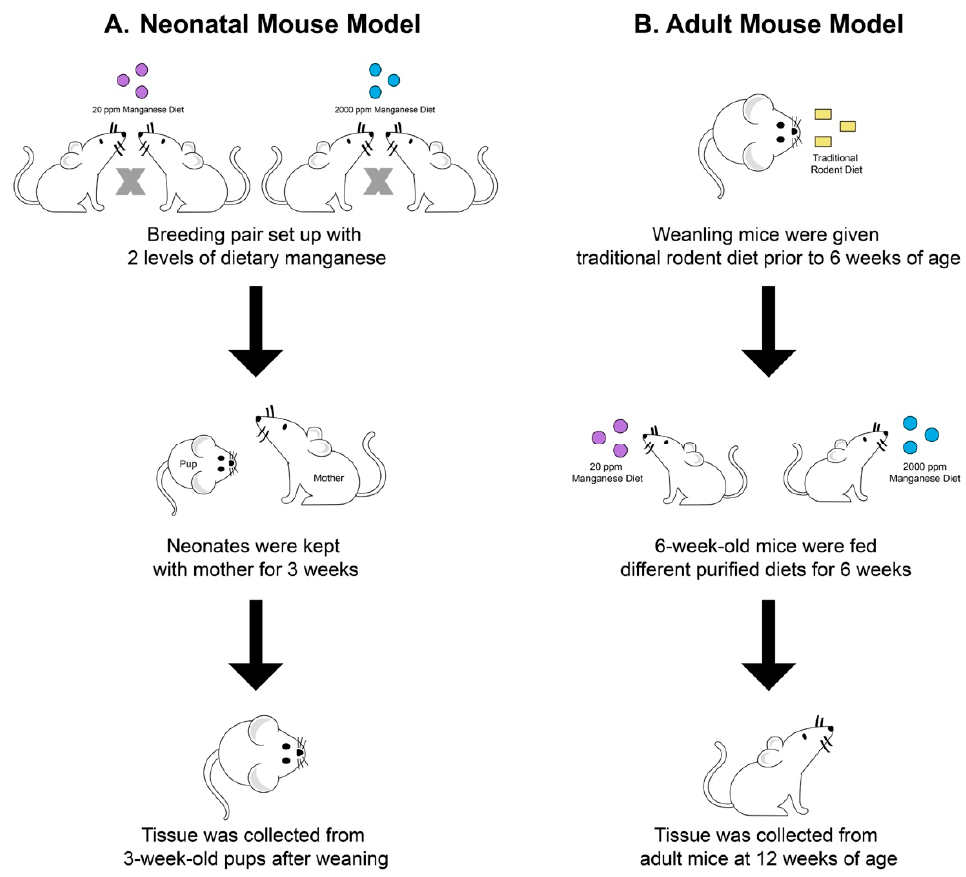
Figure 8. Schematic illustration of experimental procedures for establishing the two animal models. In the neonatal manganese overload model ( A ), 8–9-week old mating mice were fed diets containing